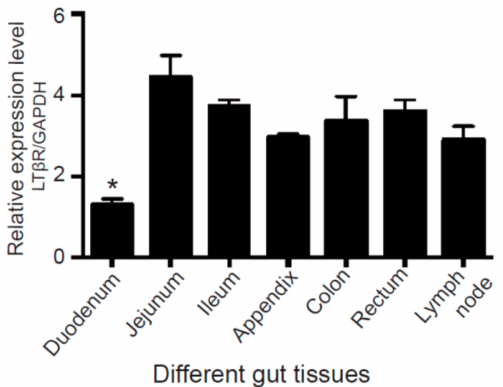
Figure 1. Expression of the lymphotoxin beta receptor (LT β R) in different porcine gut tissues. Tissues, including the duodenum, jejunum, ileum, appendix, colon, rectum and lymph nodes, were collected from adult male Large White pigs ( n = 4), and real-time PCR was used to measure the expression level of LT β R. * p < 0.05 was considered statistically significant. Note that the duodenum showed significantly lower expression of LT β R than other gut